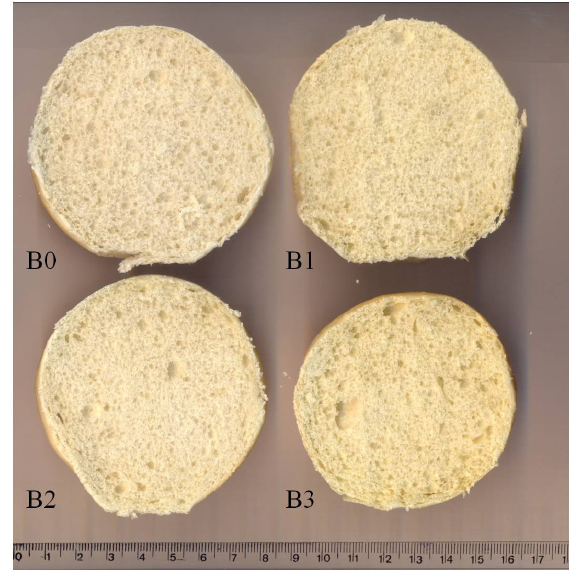
Figure 1 - Breads produced with sweet potato flour (SPF). B0 = 0% of SPF; B1 = 3% of SPF; B2 = 6% of SPF; B3 = 9% of